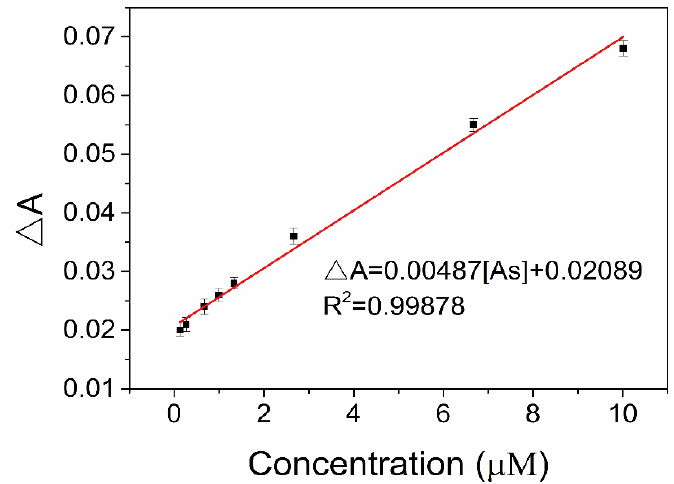
Figure 8. Plot of decreased longitudinal SPR absorption intensity (ΔA ) against As(III) concentration over the linear range of 0.13–10.01 μM.